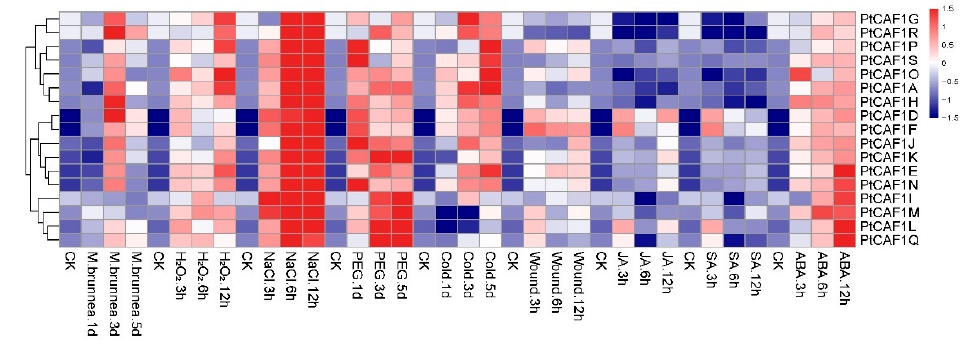
Figure 7. The expression profiles of the PtCAF1 gene family in poplar under abiotic or biotic stresses and phytohormone treatments. The heatmaps were constructed using the R package based on the expression datasets. Expression levels are represented in various colors, with red indicating higher expression levels and navy indicating lower expression levels.